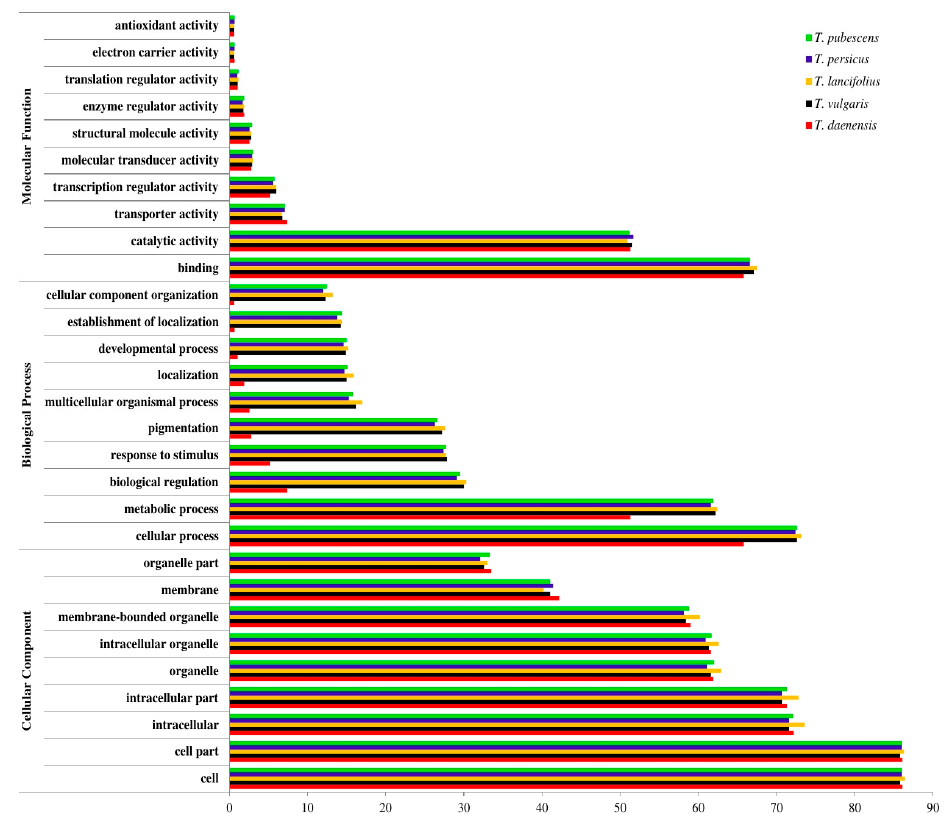
Figure 2. Gene ontology (GO) classification map derived from Thymus transcriptomes. The results are summarized in three GO categories: biological process, molecular function, and cellular component. The x-axis indicates the percentage of sequences in each